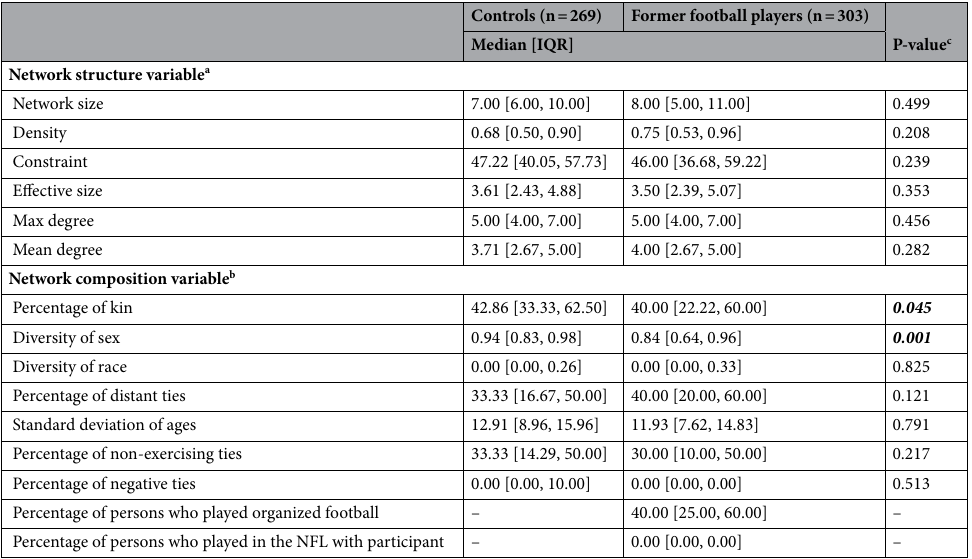
Table 2. Network variables of former NFL football player and controls, adjusted. a Network Structure is a quantitative description of the arrangement of social ties in each individual’s personal network. See definition of each term in “Methods”. b Network composition is the range of characteristics of people around the individual. See definition of each term in “Methods”. c P-value calculated from multivariable linear regression adjusting for age, race, education, employment status, median yearly income, and domestic status.